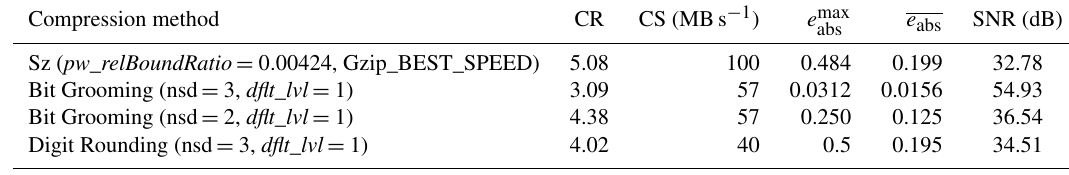
Table 6. Compression results of the relative error-bounded compression algorithms Sz, Bit Grooming, and Digit Rounding on dataset s1 . Compression method